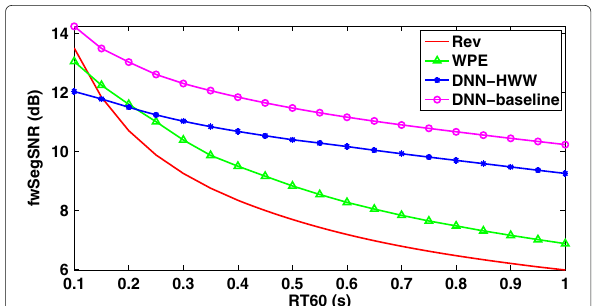
Fig. 6 Average single-microphone fwSegSNR of WPE, DNN-HWW, and DNN-baseline at different